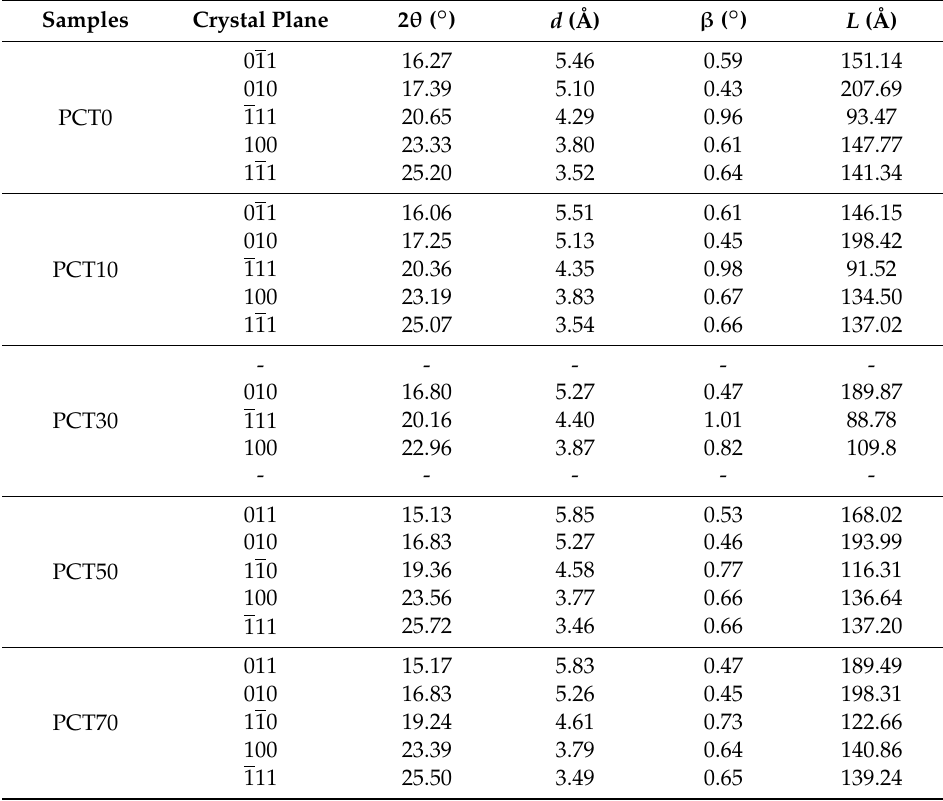
Table 4. WAXD data of the (PBT-co-PCT)-b-PTMG copolymers.